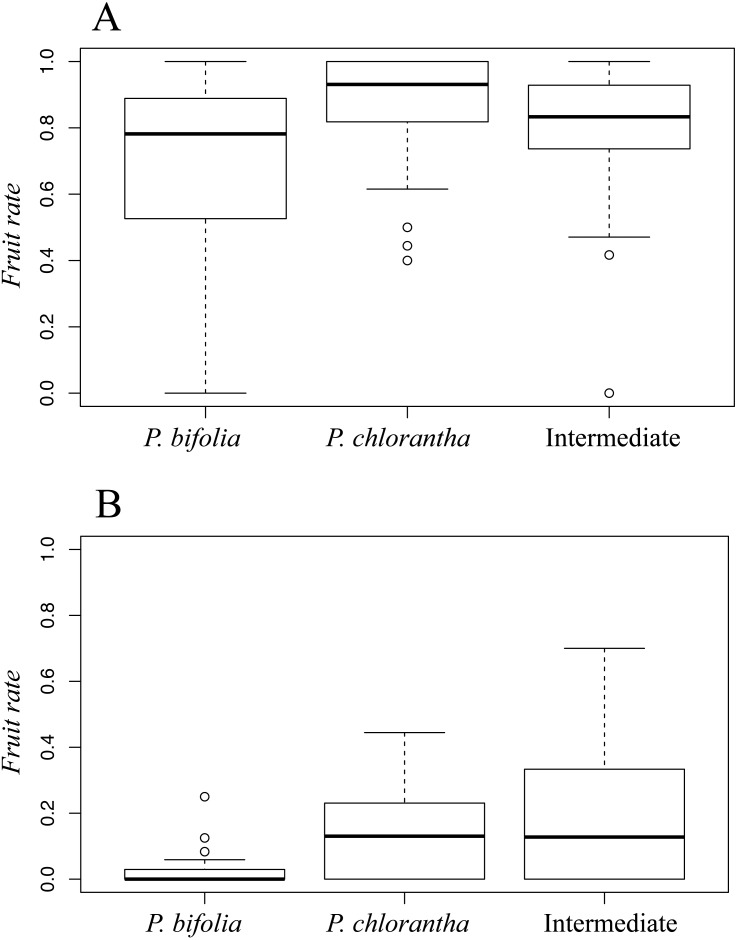
Fruit set in P. bifolia, intermediates and P. chlorantha of Botton (A) and Bois (B) Niau sympatric zones.Bars indicate means and standard errors.